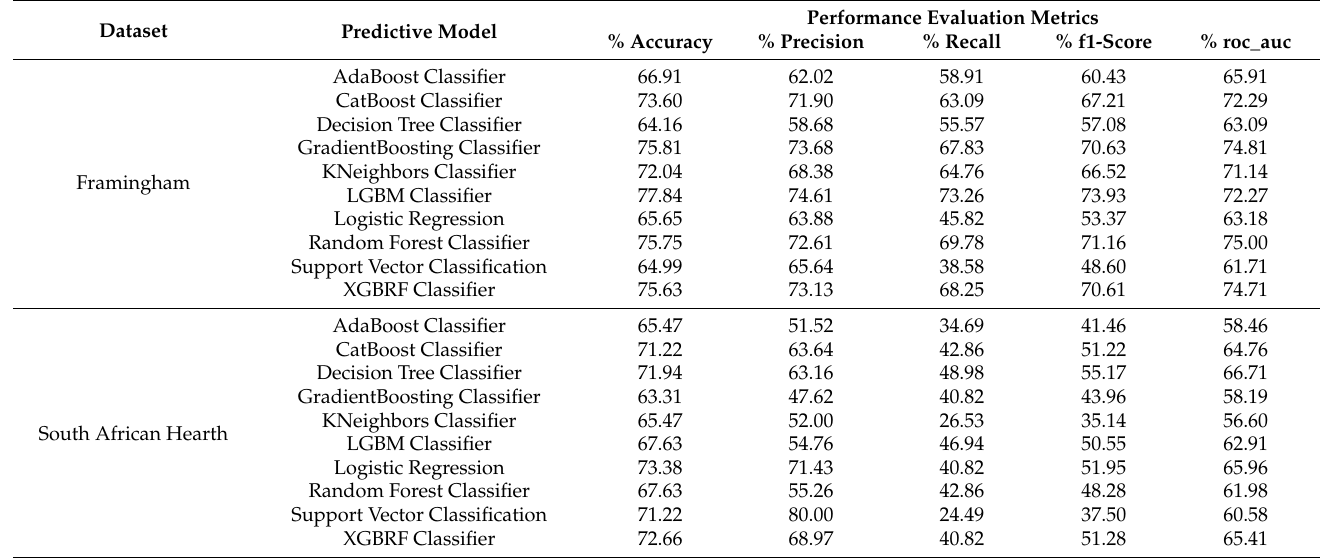
Table 8. Train-test set performance evaluation of ML classifiers on the top-two attributes from the Framingham and the South African Hearth